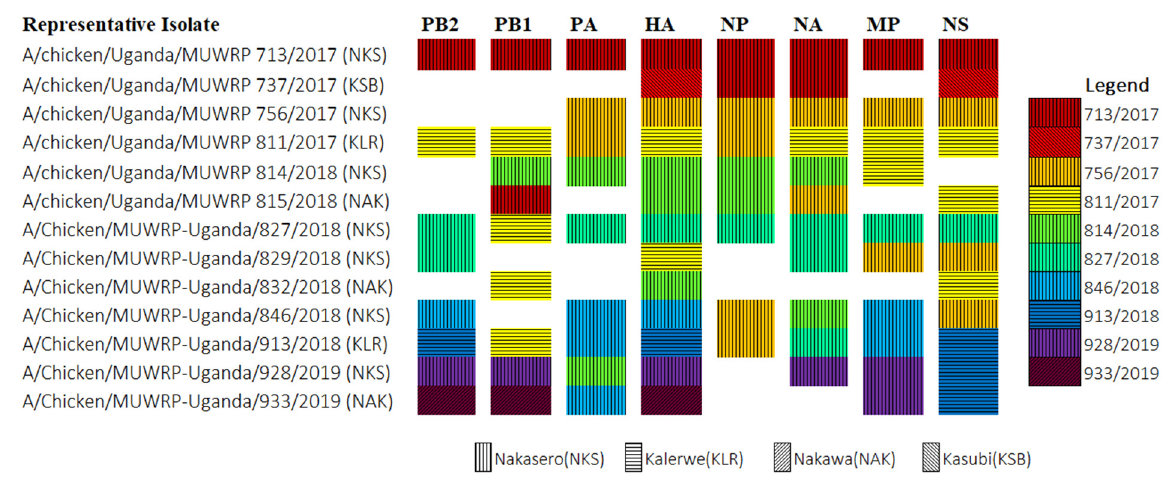
Figure 4. Reassortment within Ugandan H9N2 viruses. Clades were created in each segment by collapsing all branches with length < 1. From these, the oldest virus isolate was selected and those from the HA segment were given a color code. Representative isolates were cross-referenced to see if they fell within the same clades across all segments. Symbols for markets of origin were also assigned and overlaid.